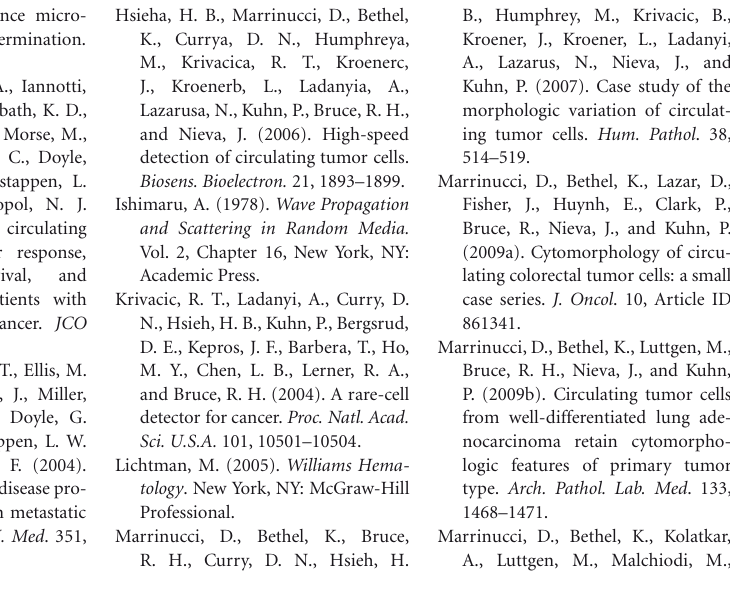
(C) Box plot comparing population averages of the axial resolved DIC intensity spatial correlation length among PLTs, RBCs, leukocytes, and HD-CTCs. *Denotes p < 0 . 001 in comparison to